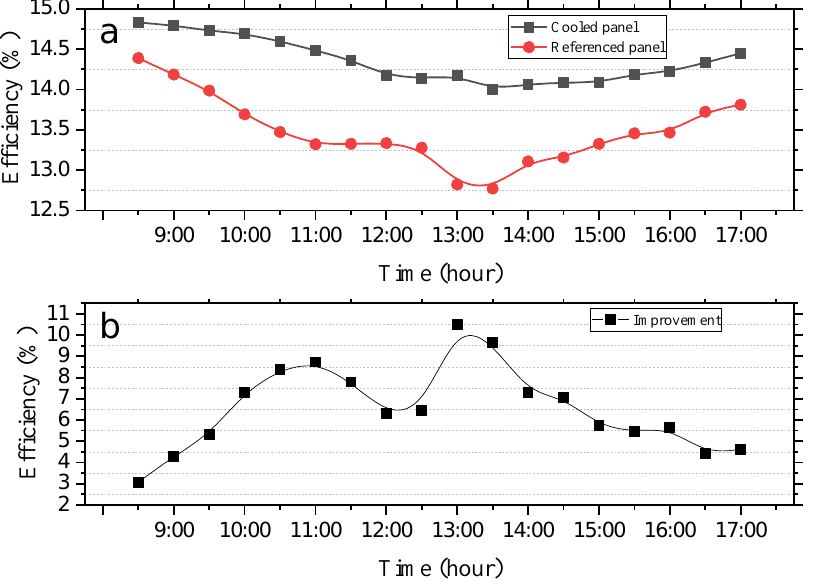
Figure 11. ( a ) Efficiency and ( b ) improvement in efficiency.